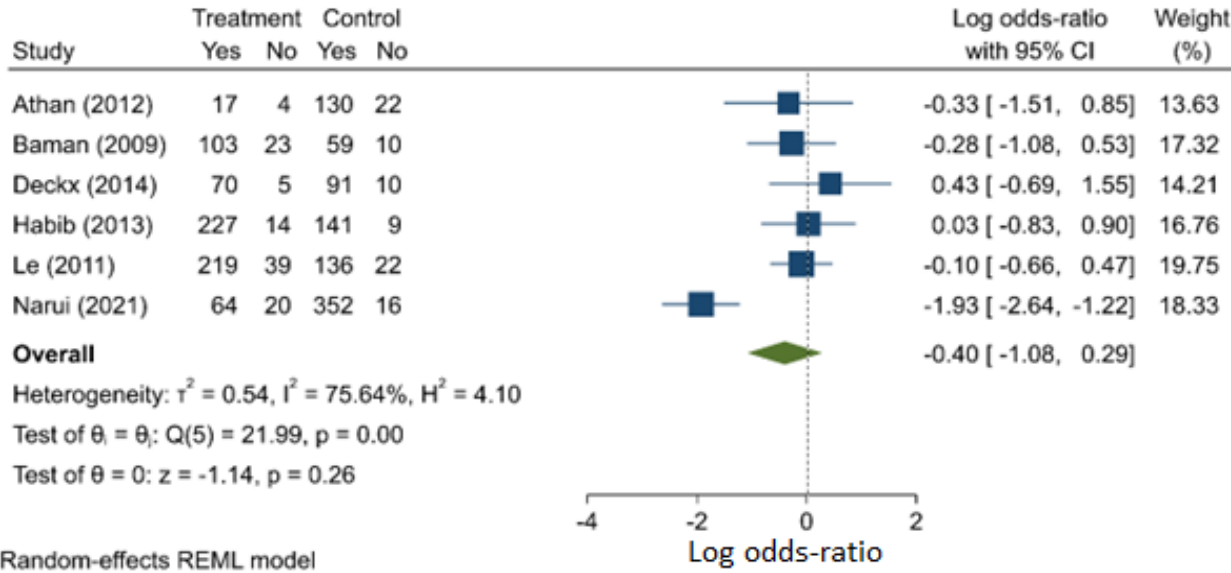
Figure 7. Implantable cardioverter defibrillator compared with anti-bradycardic CIED (pacemaker) as a risk factor for mortality.